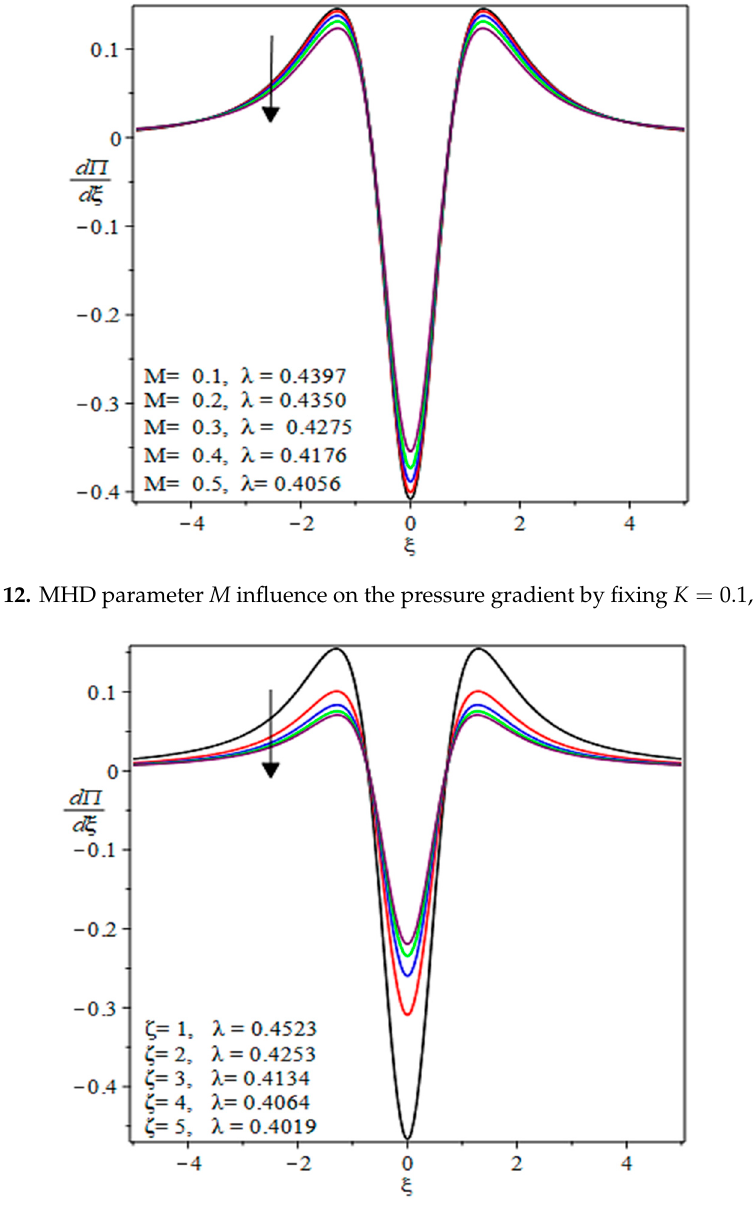
ζ ζ influence on the pressure gradient by fixing = 0.1 K , = 1 M . Figure 13. Viscoelastic parameter ζ influence on the pressure gradient by fixing K = 0.1, M = influence on the pressure gradient by fixing = 0.1 K , = 1 M .